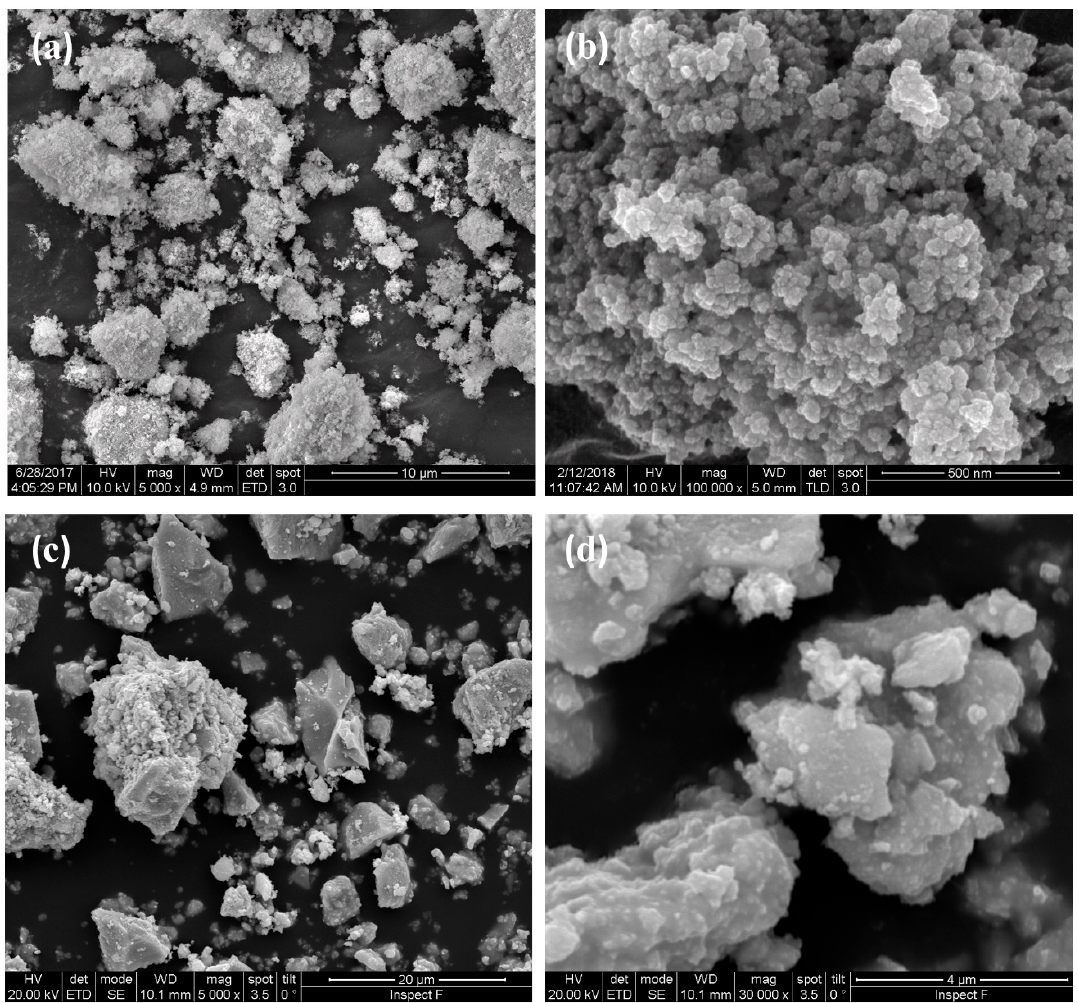
Figure 3. SEM micrographs of calcined SPDC-AC ( a , b ) and SPDC-NH3 ( c , d ) powders.